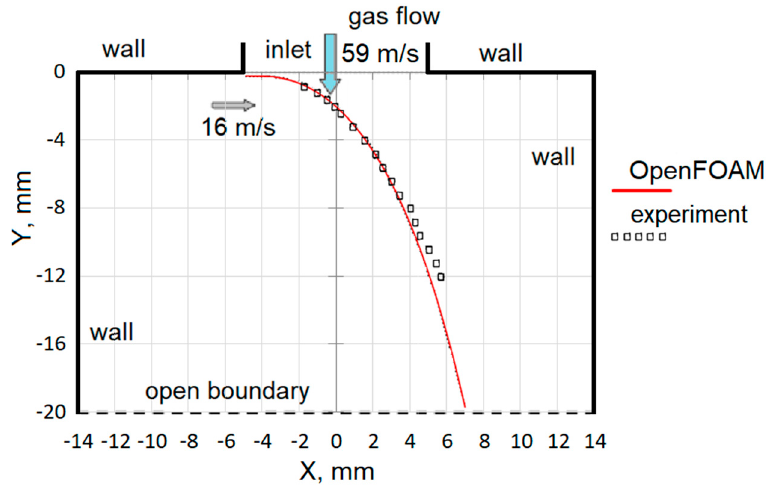
Figure 3. Problem statement: droplet trajectory in the flow.